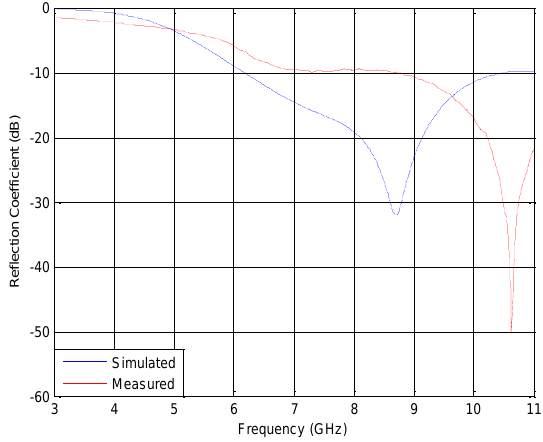
Fig. 8 : Reflection coefficient of Antenna-2.